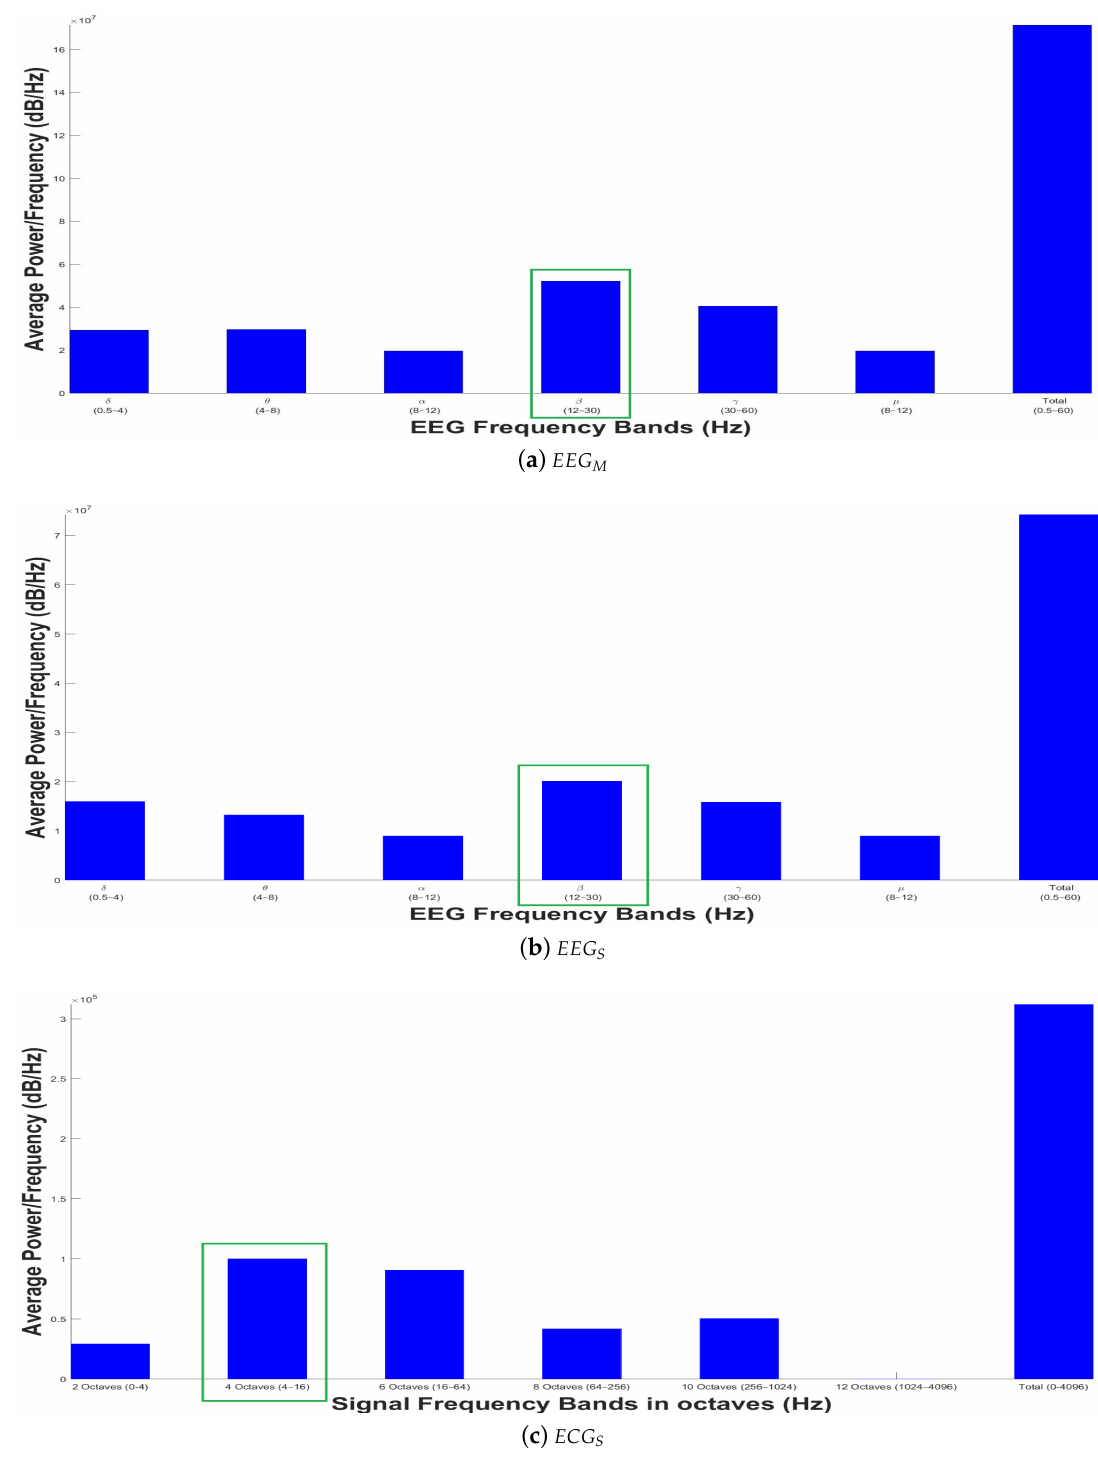
Figure 28. Analysis of biomedical signal interfaces: Average